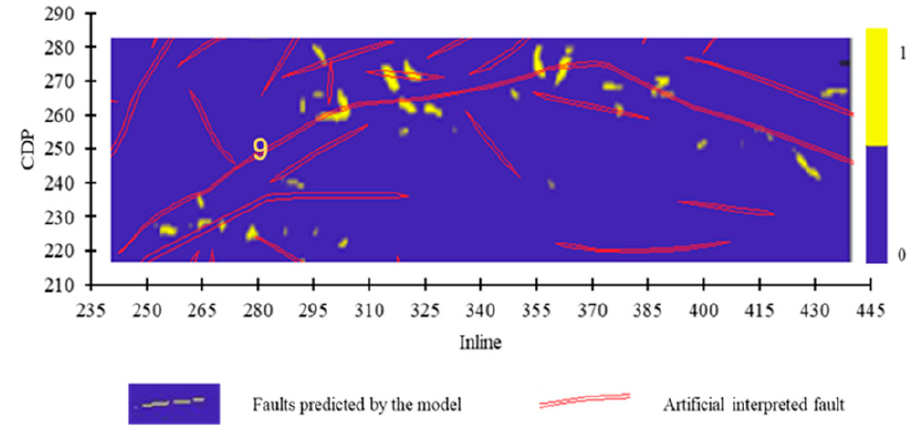
Figure 15. The prediction result of faults as a training set (Reprinted from Ref. [100]).